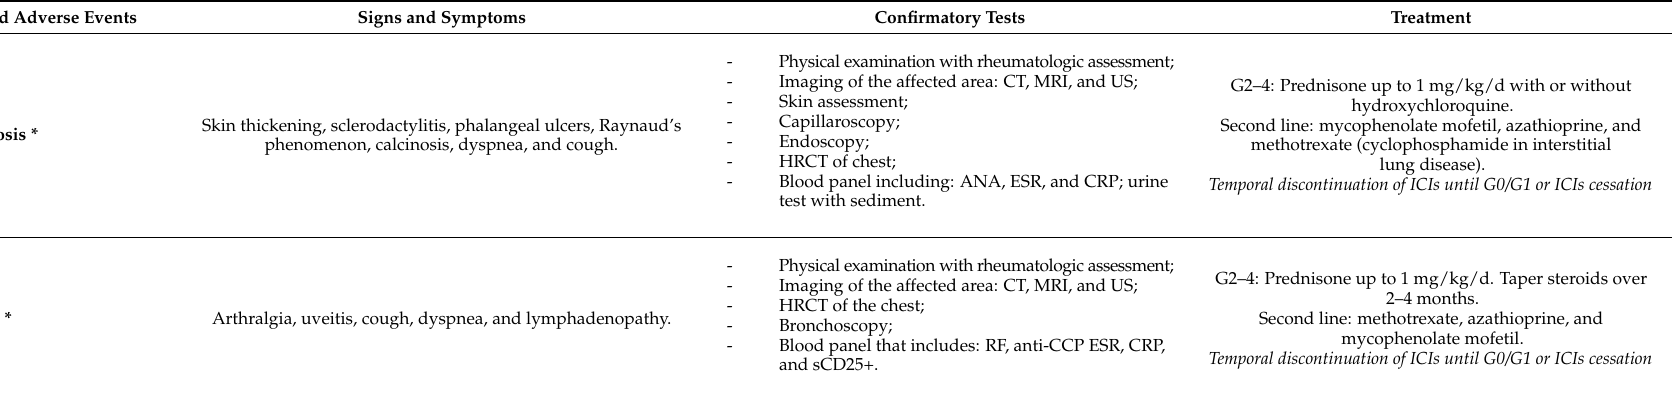
Table 2 references: [8,10,57–61] *—lack of specific guidelines for ICIs-related systemic sclerosis and sarcoidosis. Treatment recommendations are presented as for the classic forms of these diseases. Abbreviations (in alphabetic order): AChR—acetylcholinesterase antibodies, ALT—alanine aminotransferase, ANCA—antineutrophil cytoplasmic